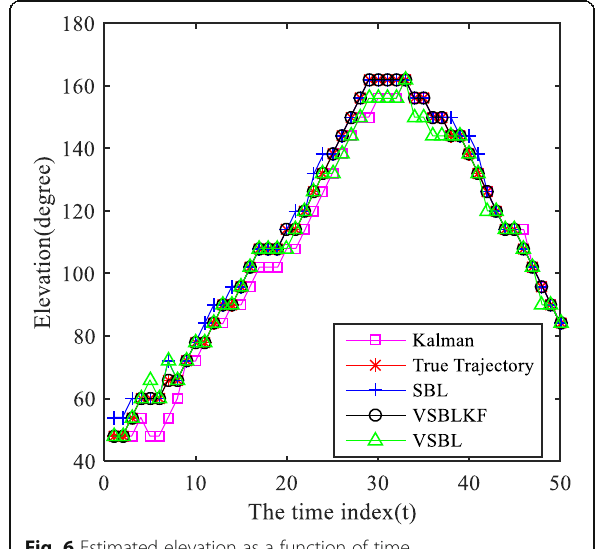
Fig. 8 Estimated elevation error as a function of